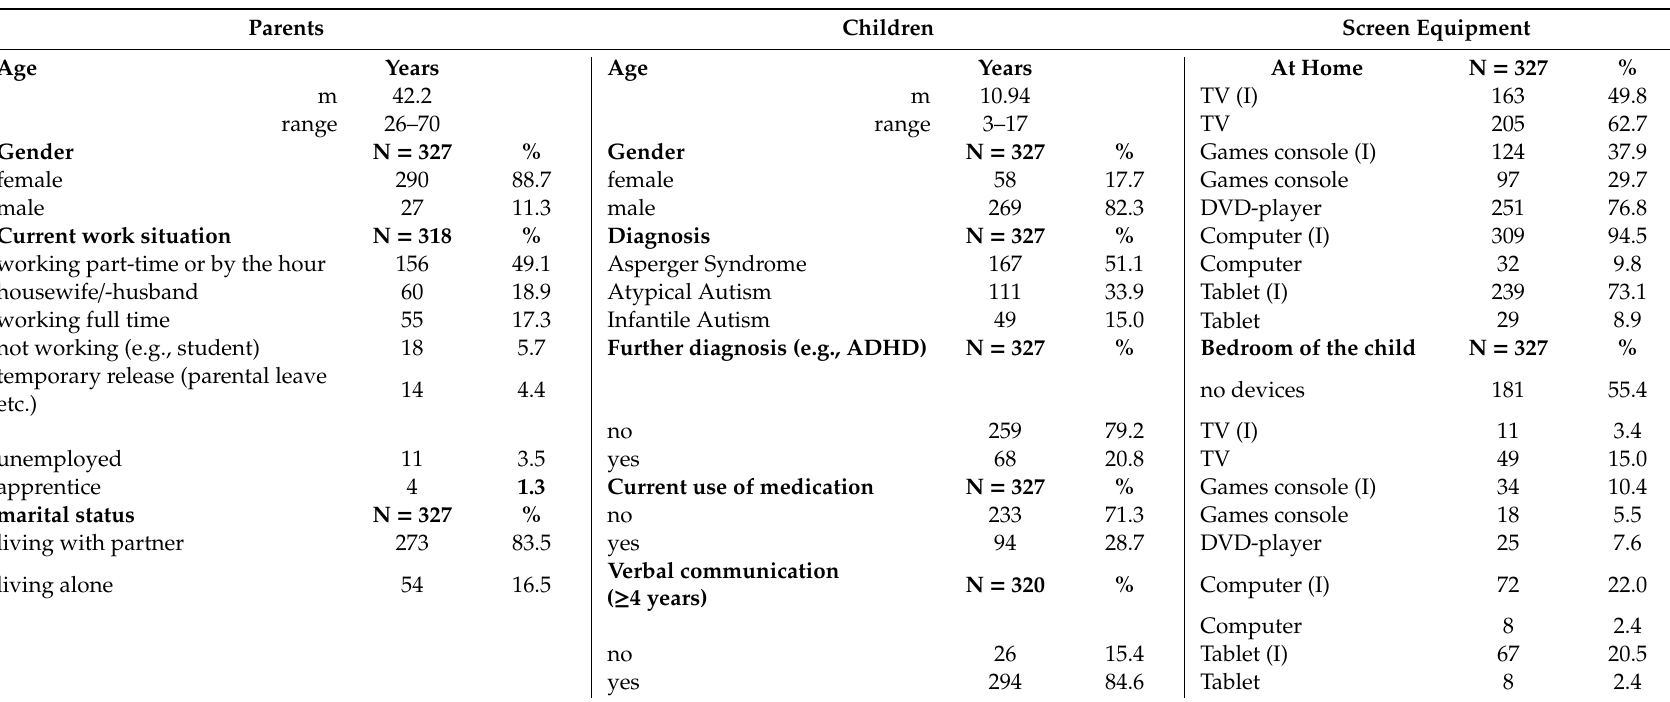
Table 4. Basic characteristic of the participants in the online survey and their child as well as the screen equipment (home, bedroom of the